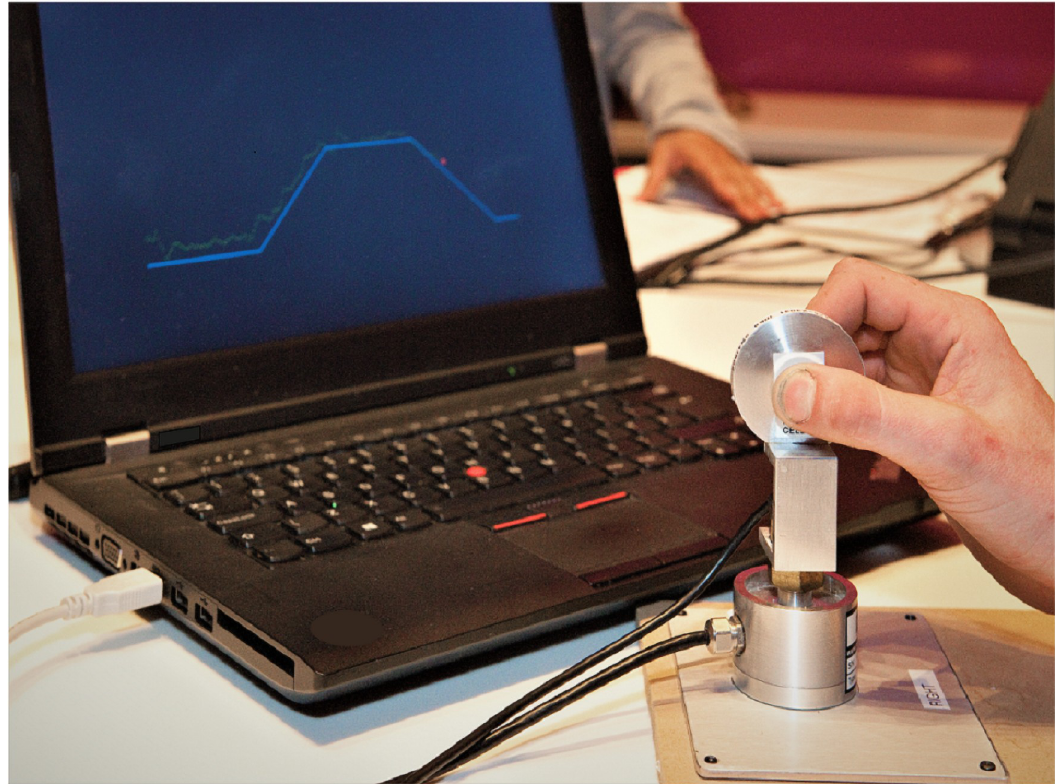
Fig 1. Picture of the equipment in use. The participant is gripping a load cell between finger and thumb. The participant’s task is to pull up on the second load cell to match a force trace that appears on the laptop monitor. The current load force is shown as a red circle, and the history of the participant’s force is shown as a trail of green